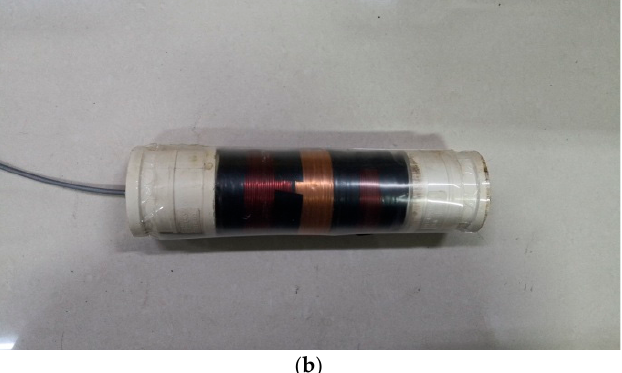
Figure 5. Specifications of the probe: ( a ) Probe; ( b ) Photo of the probe